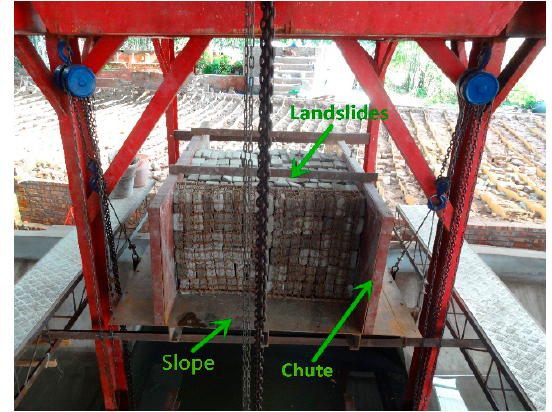
Figure 3. Arrangement of sliding blocks.